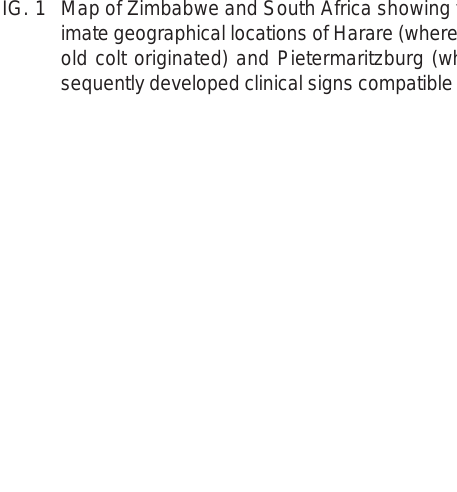
TABLE 1 Virus isolates included in the phylogenetic comparison Lab.